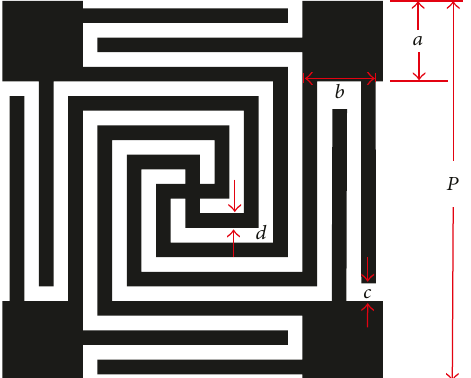
Figure 1: Unit cell of proposed FSS.